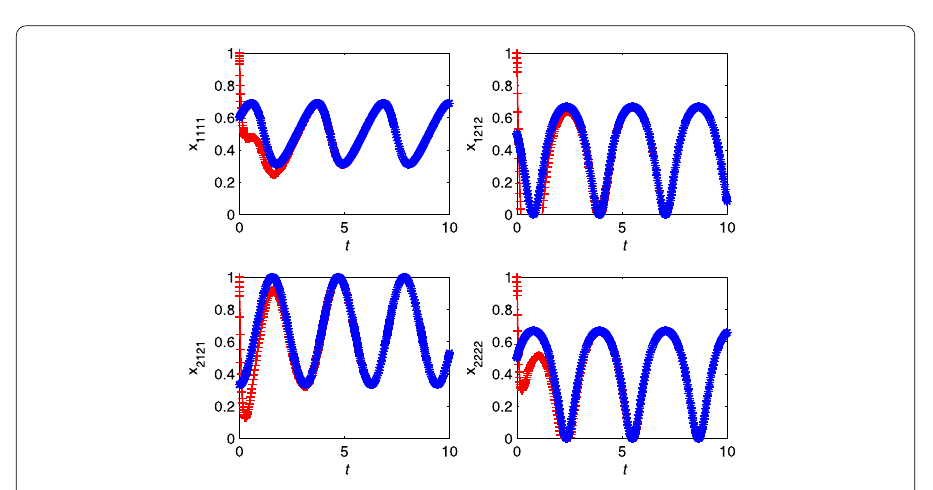
Figure 4 The trajectory of some neural states synthesized by NTCTZNN2